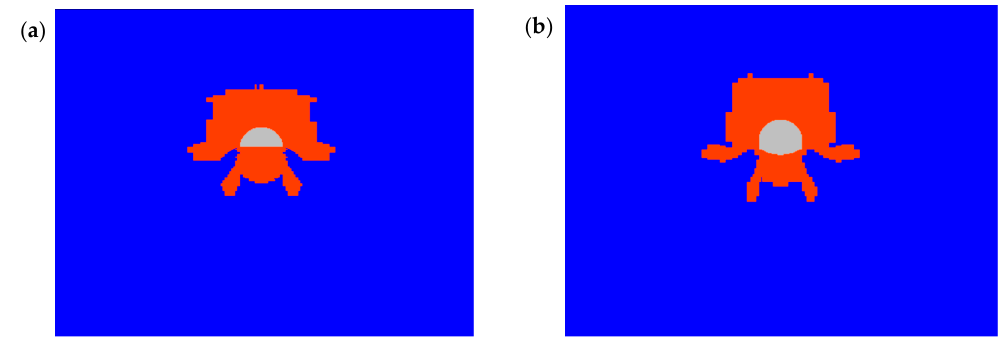
Figure 16. Permeability coefficient increment distribution diagram of surrounding the rock after blasting. ( a ) upper section. ( b ) full cross-section.